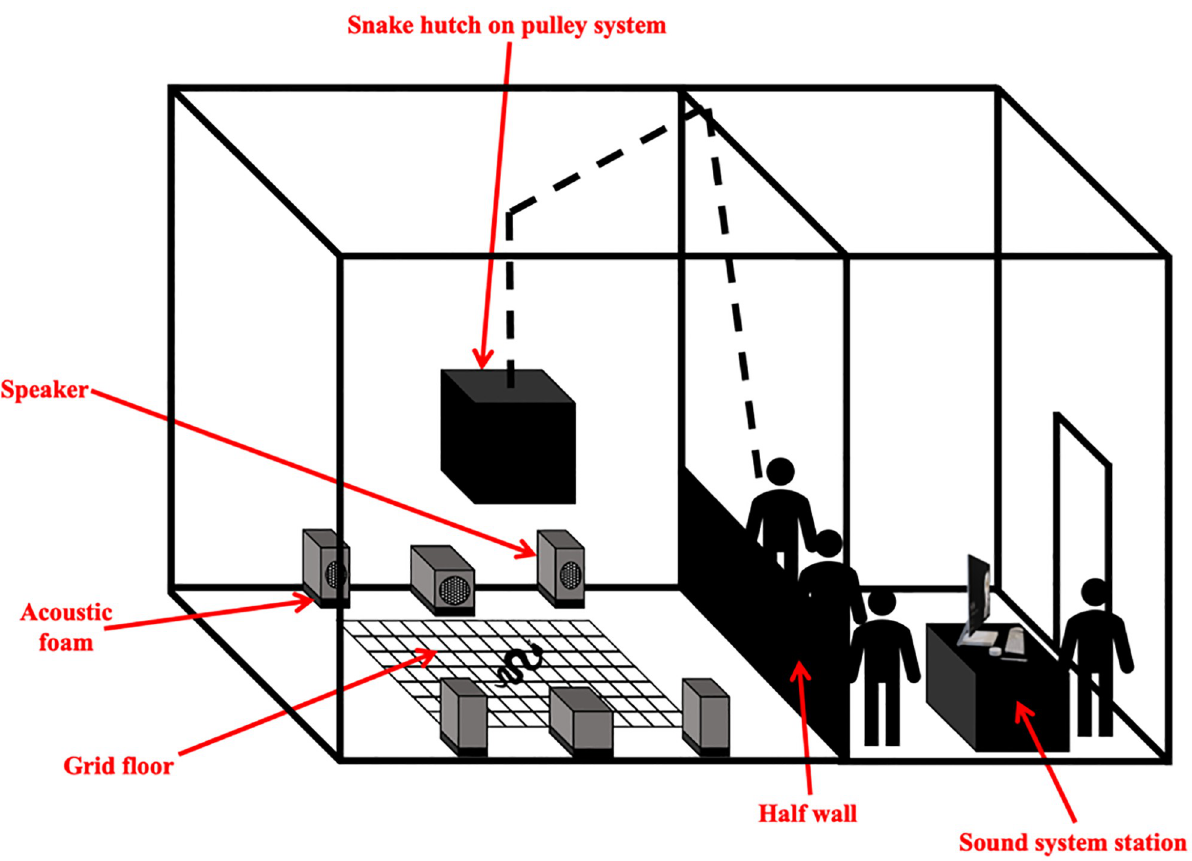
Fig 1. Diagram of sound-proof room for controlled trials. The experimental set-up is shown on the left side, and the data collection area and sound system station are shown on the right side. Image not made to scale. See text for dimensions.